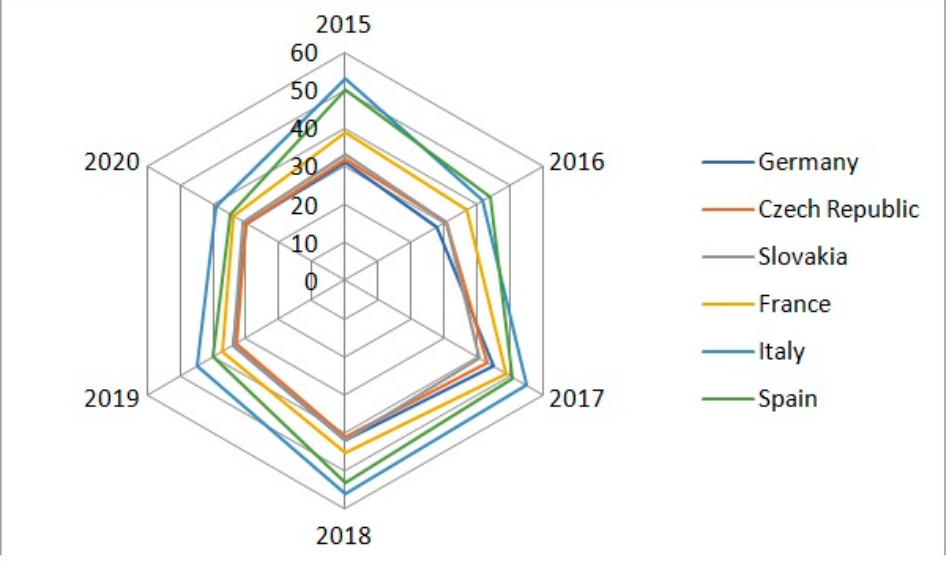
Figure 23. Average wholesale electricity prices on the spot market (EUR/MWh) [70]. The report prepared by the Institute for Renewable Energy (EC BREC IEO) allows to indicate the forecast of production costs and prices of electricity (wholesale) until 2040 in Poland (Figure 24), showing an upward trend in both energy prices and costs. It is worth adding that we also notice cost stabilization—proportional energy appreciation.